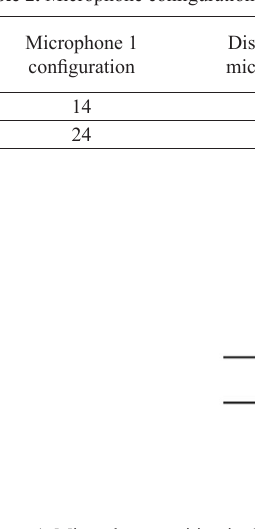
Figure 1. Microphone position in the impedance tube.